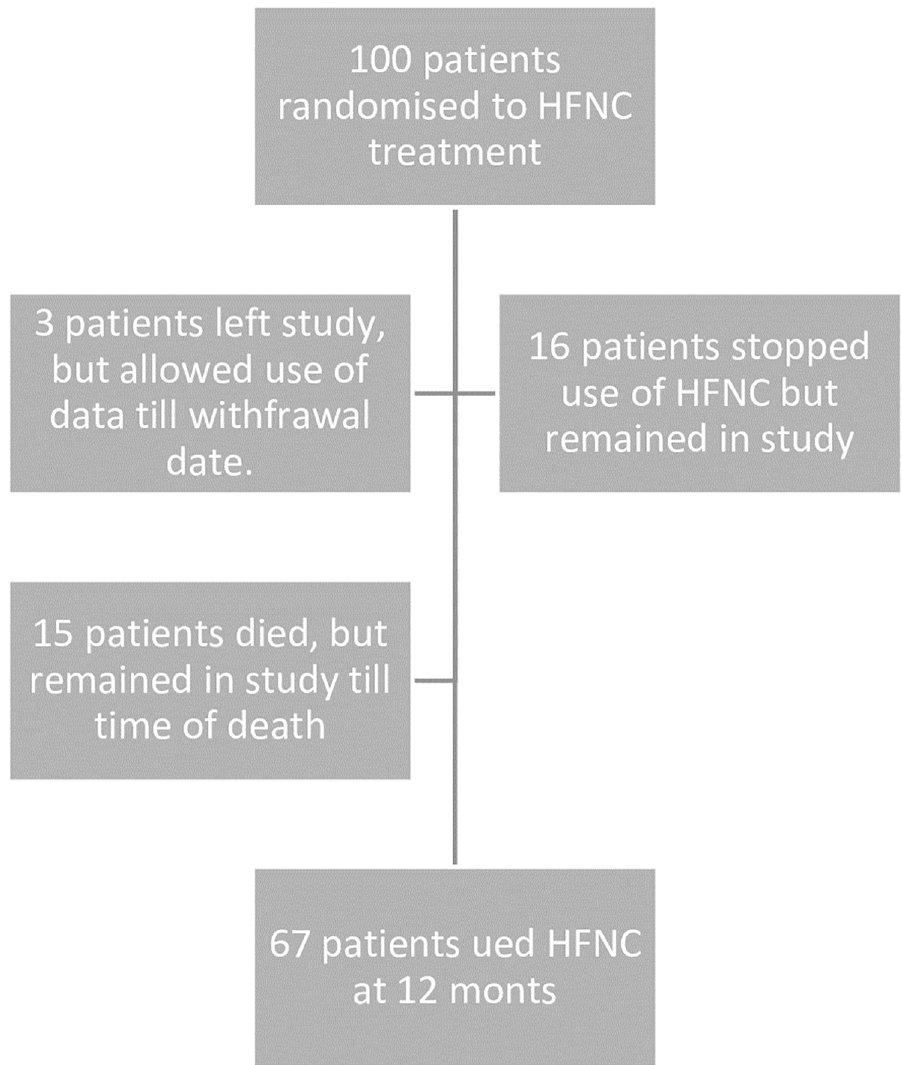
Fig 1. Flow diagram of patients included in the post hoc